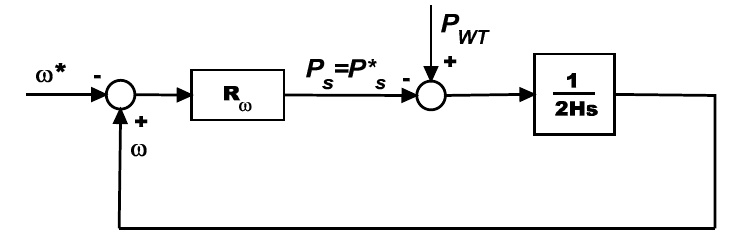
Figure 12. Simplified speed control loop for the synthesis of the regulator.